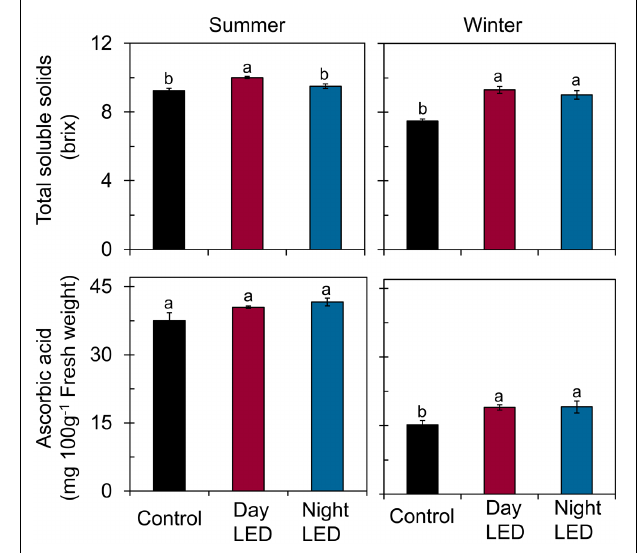
FIGURE 5 | Shoot dry weight and fruit yield of single-truss tomato plants. Measurements were made in plants grown under daytime or nighttime LED inter-lighting or control. Data represent means ± SE ( n = 5 and 15 for dry weight and fruit yield, respectively). Different letters indicate statistically significant differences (Tukey’s HSD at P < 0.05).